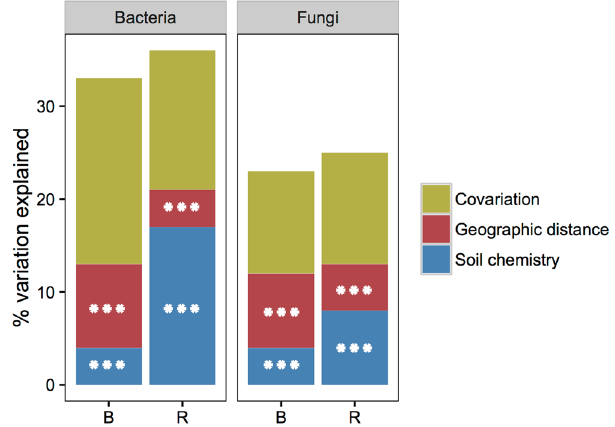
Figure 4. Partitioning of the variation in bacterial and fungal community structure. The specific effects of soil chemistry and geographic distance and the total co-variation (i.e., the variance jointly explained by the soil chemistry and geographic distance) are represented. Statistical significance is indicated by *** P < 0.001. B, bulk soil; R, rhizosphere soil.